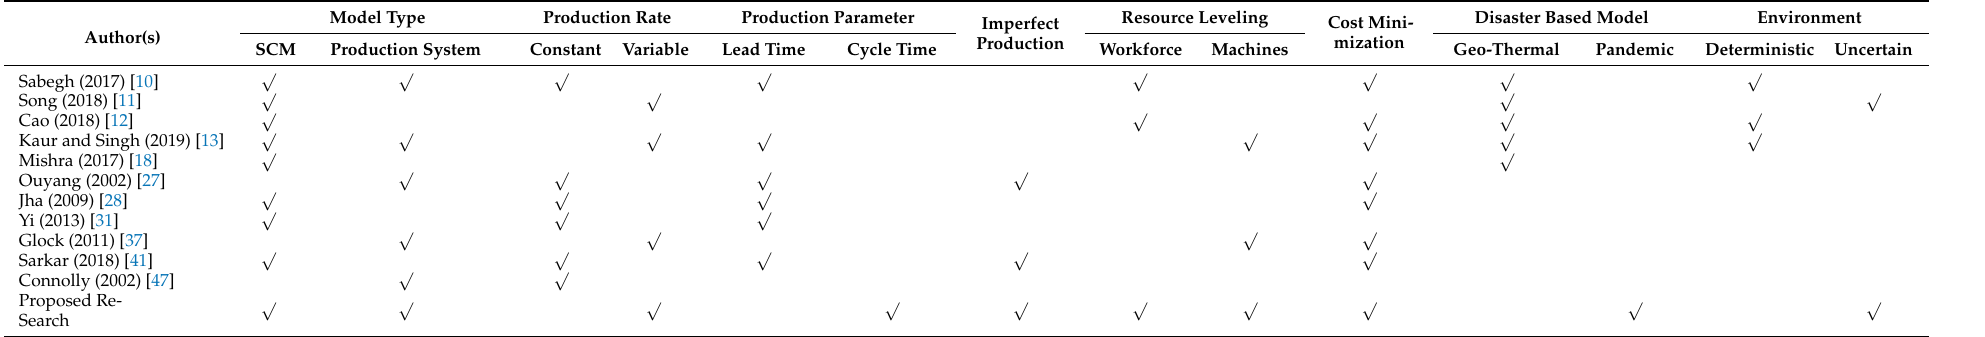
Table 1. Previous author relevant contributions in the